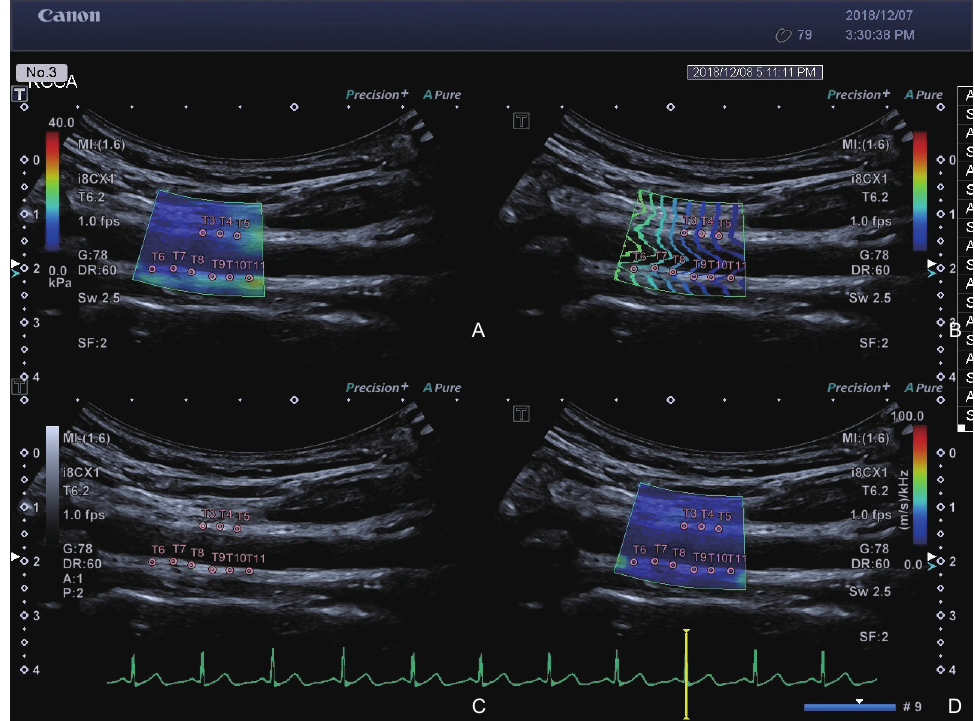
C Figure 1 QuadView of shear wave profile. (A) Elastic map. The shear wave speed is coded on a color scale from blue to red, corresponding to ranging the Young modulus between 0.0 and 40.0 kPa; (B) Propagation map. The contour lines represent shear wave arrival times at different points in the tissue; (C) Two-dimensional reference map; (D) Shear wave dispersion map. The shear wave dispersion is also coded on a color scale from blue to red, corresponding to value of dispersion from 0.0 to 100.0 (m/s)/kHz.